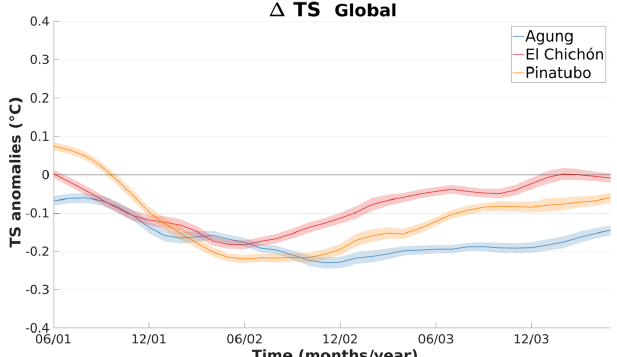
Figure A1. Evolution of the ensemble mean of the global cooling in the three eruption cases for 3 years, starting at the first summer after the eruption. The 3-year climatology is subtracted to calculate the anomalies. Shading represents twice the standard error of the ensemble mean (i.e. ∼ 95% confidence interval).